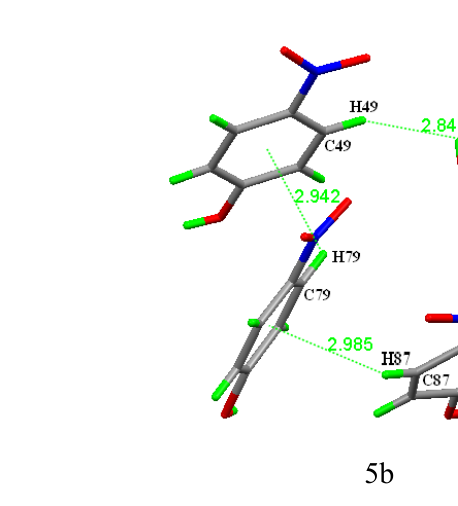
Figure 5. The C-H··· π structures in the two different 4-nitrophenol assemblies.